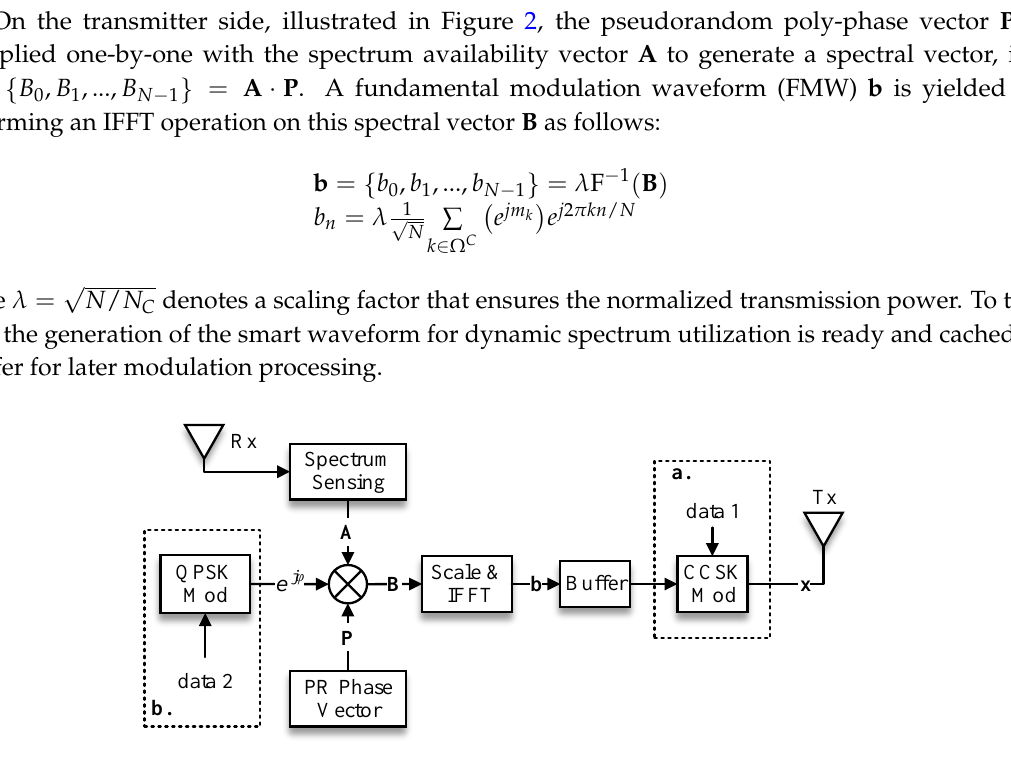
Figure 2. Block diagram of the TDCS transmitter (two modulation methods in one general diagram).